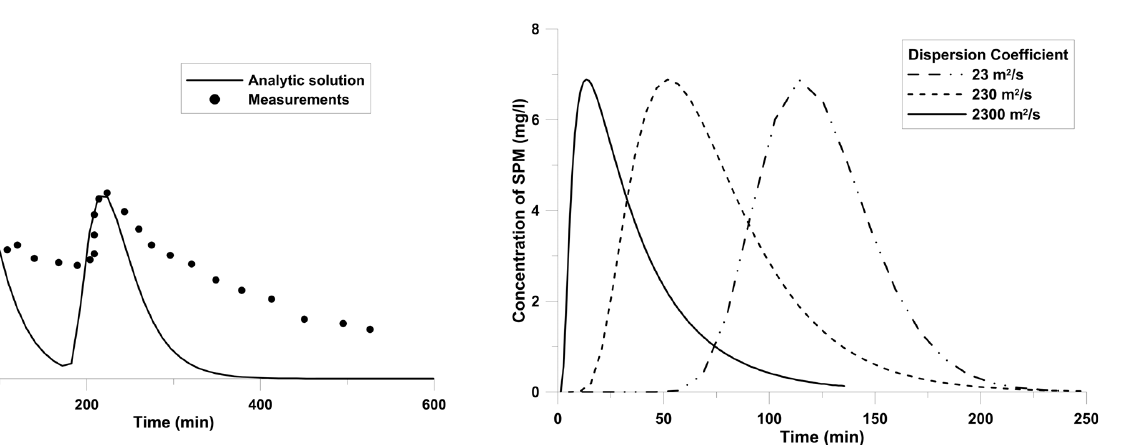
C:\Documents and Settings\brigitte.wilhelm\Desktop\Subversion\Journals\hess\hess-2011-329\author\hess-2011-329-manuscript- version4.doc